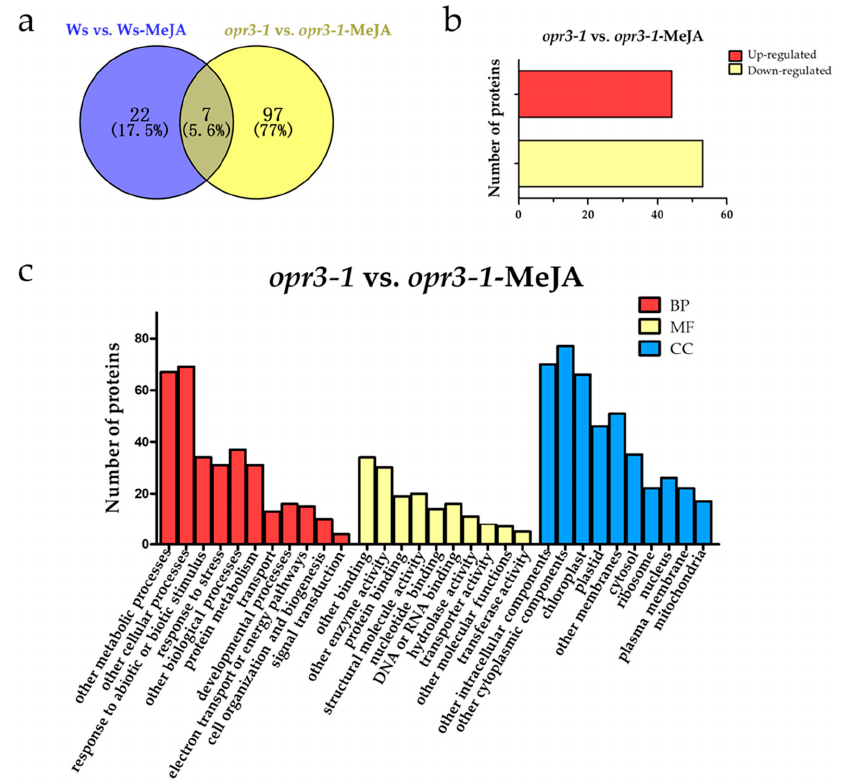
Figure 2. Functional classifications of di ff erentially regulated proteins. ( a ) A Venn diagram of di ff erentially regulated proteins; ( b ) the numbers of up-regulated and down-regulated proteins; ( c ) GO assignment of DRPs in opr3-1 in response to methyl jasmonate (MeJA) treatment ( opr3-1 -MeJA). BP: Biological Process; MF: Molecular Function; CC: Cellular